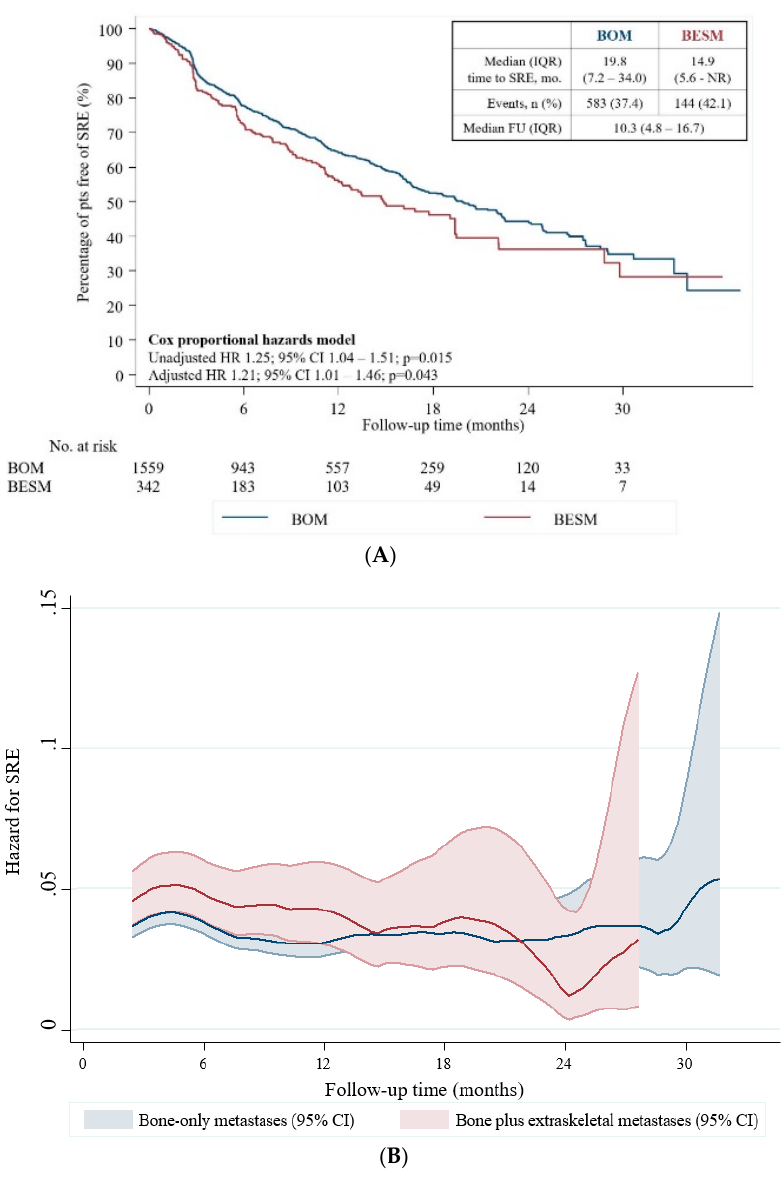
Figure 2. ( A ) Time-to-first on-study SRE; ( B ) Hazard for first on-study SRE.BESM, Bone and extraskeletal metastases; BOM, bone-only metastases; CI, confidence interval; ESD, extraskeletal disease; HR, hazard ratio; IQR, interquartile range; NR, not reached; pts, patients; SRE, skeletal-related event. Table 3. Risk for development of first on-treatment SRE. Characteristic